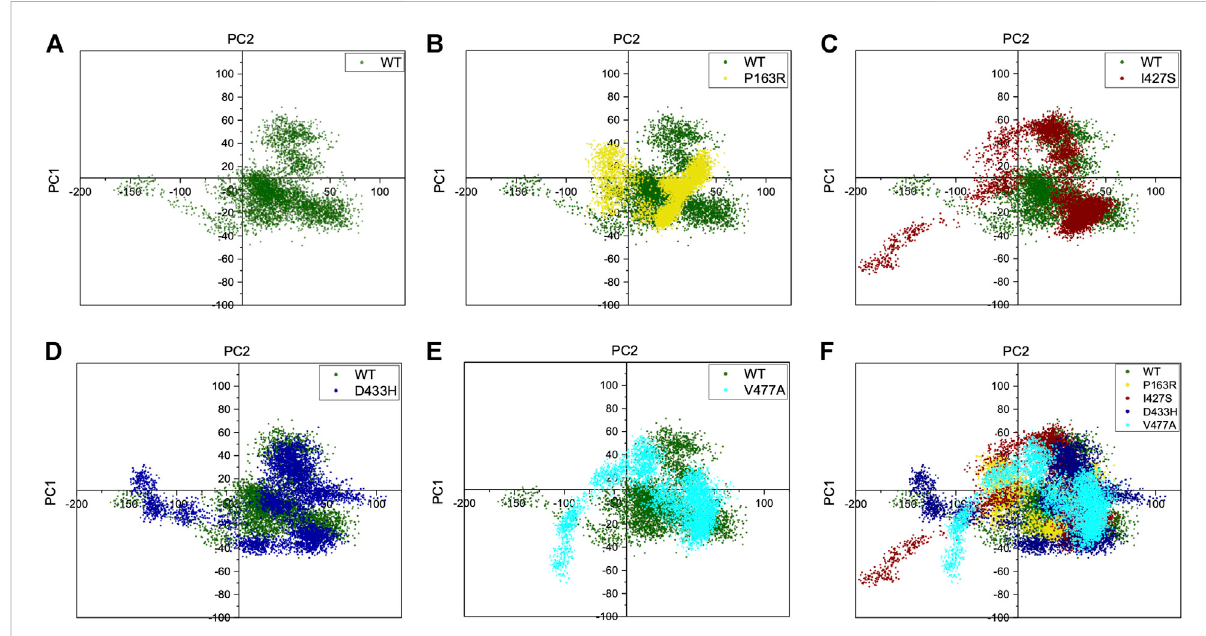
FIGURE 8 ProjectionofC-alphaatomsinessentialsubspacealongwiththe fi rsttwoprincipalcomponents(PC1andPC2)obtainedfromWT,P163R,I427S, D433H, and V477A. Figure (A) shows PC1 and PC2 of WT only. In contrast, fi gures (B – E) shows fi rst two principal components of mutants, projected over WT principal components. (F) shows an overlay of WT and all four mutants PC1 and PC2